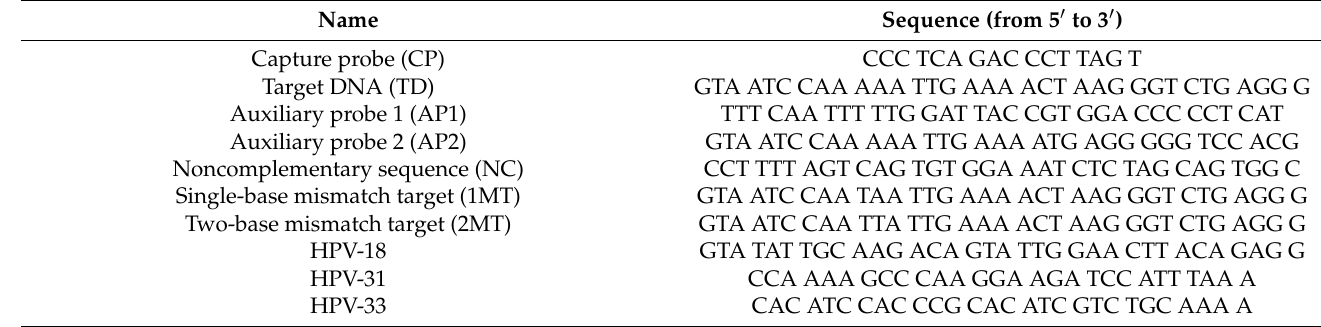
Table 1. Sequences of the oligonucleotides used in this